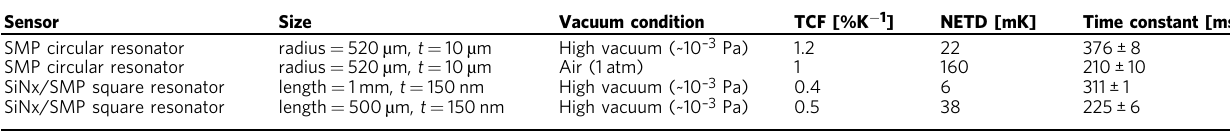
All results are measured at T sub =